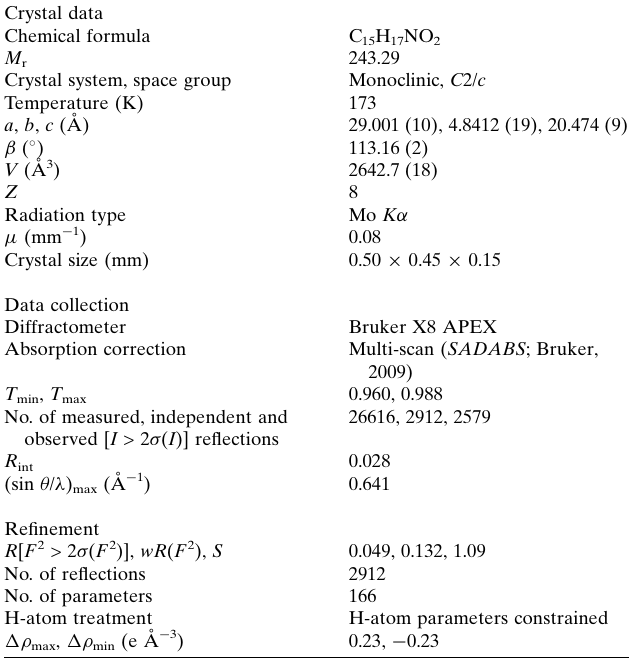
Table 1 Hydrogen-bond geometry (A˚ , (cid:2) ).